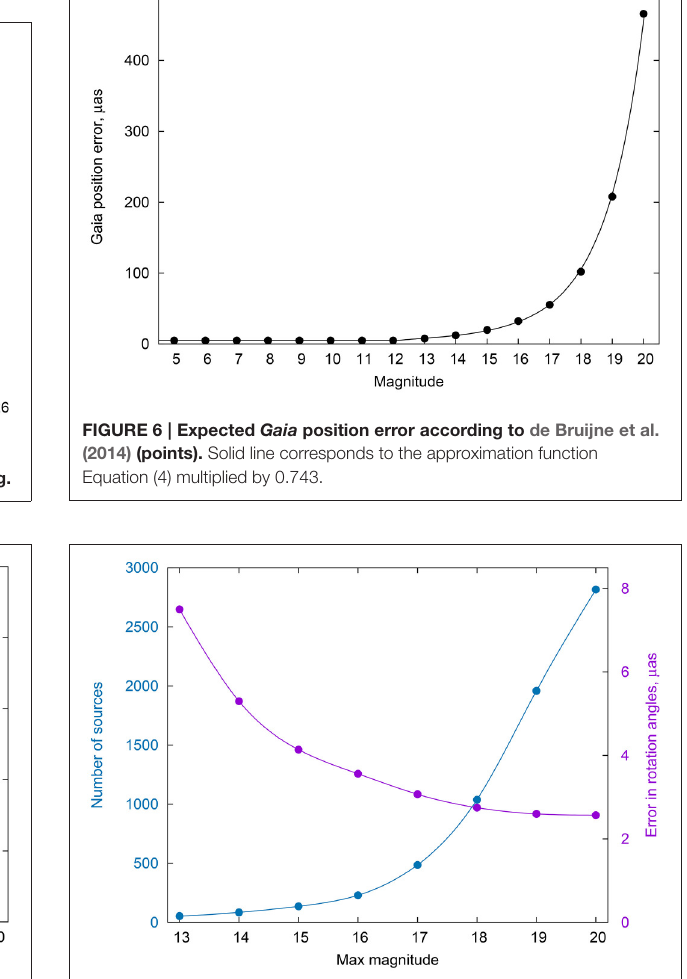
FIGURE 7 | Simulated error in orientation angles depending on source selection based on the faint-end optical magnitude